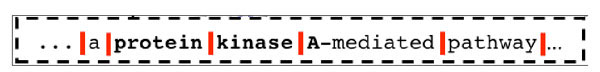
Sample phrase with problematic tokenization (red vertical bars give tokenization boundaries).